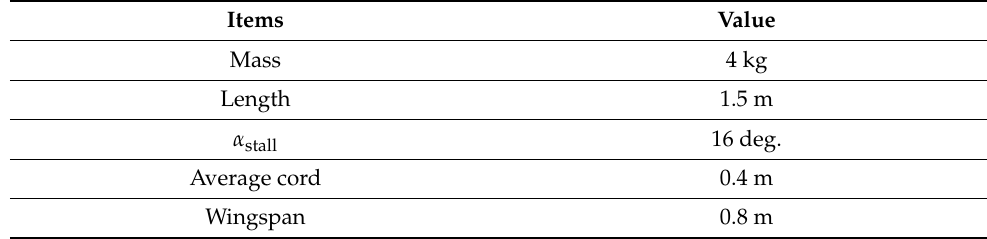
Table 1. Physical parameters of the one-third-scale Oowashi.